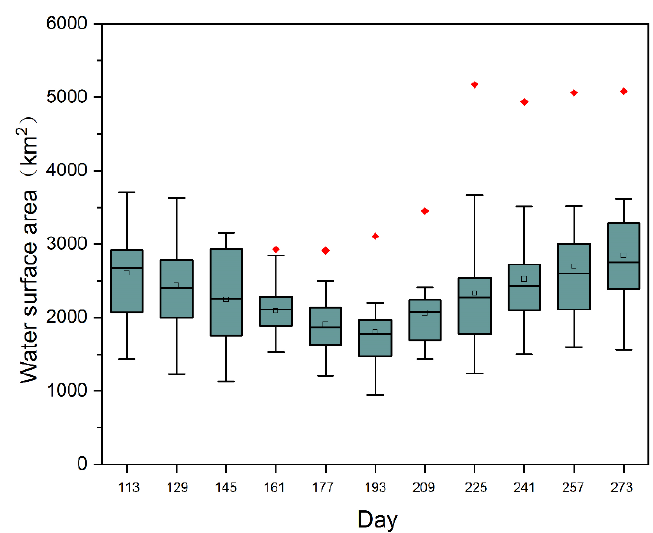
Figure 6. Changes in the total water surface area during late April and late September in the Julian day number (i.e., a non-frozen period) in the Nenjiang River Basin, Northeast China. Red solid dots denote the areas during the extreme flood event in 2013. Each boxplot illustrates the median and inter-quartile range and the whiskers indicate minimum and maximum values.